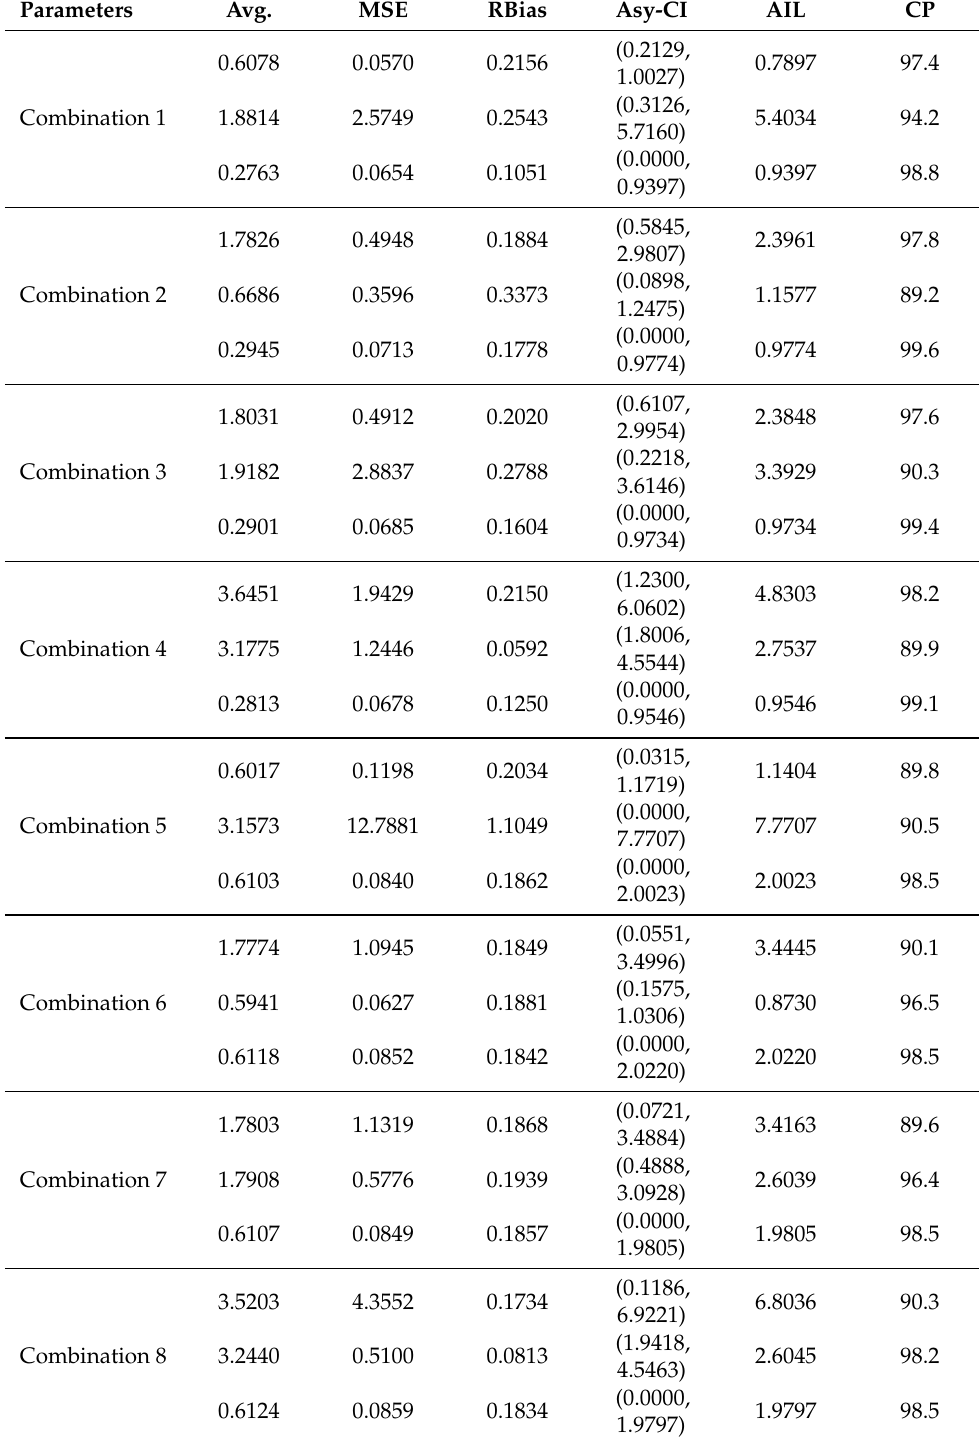
Table 8. Average estimated values, MSEs, CIs, AILs and CPs (in %) of the MLE for the FB distribution at N = 25 and n =